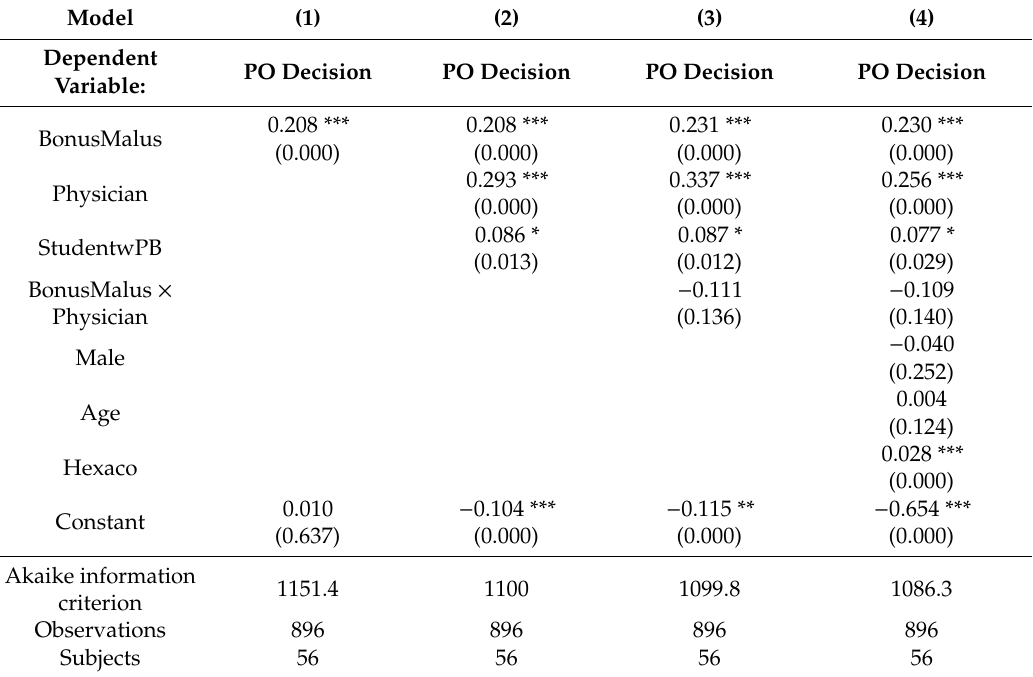
Table A12. Logit regressions for the entire subject pool—average marginal e ff